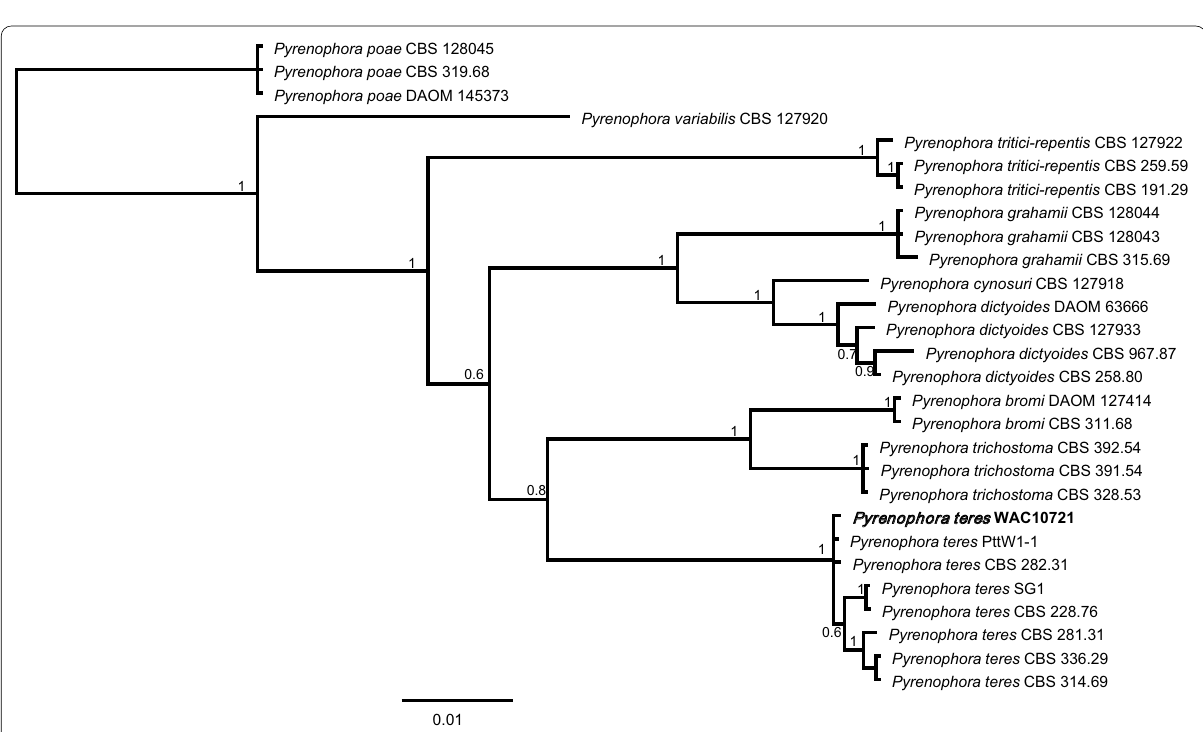
Fig. 4 The phylogeny was constructed by Bayesian inference using MrBayes (Huelsenbeck and Ronquist 2001). The sequences of four loci ITS, LSU, gapdh and tef1 were either obtained from the study of Marin‑Felix et al. (2019), or extracted from the reference genome of Pyrenophora teres from Syme et al. (2018). Sequence alignments were produced using MAFFT v.7 (Katoh and Standley